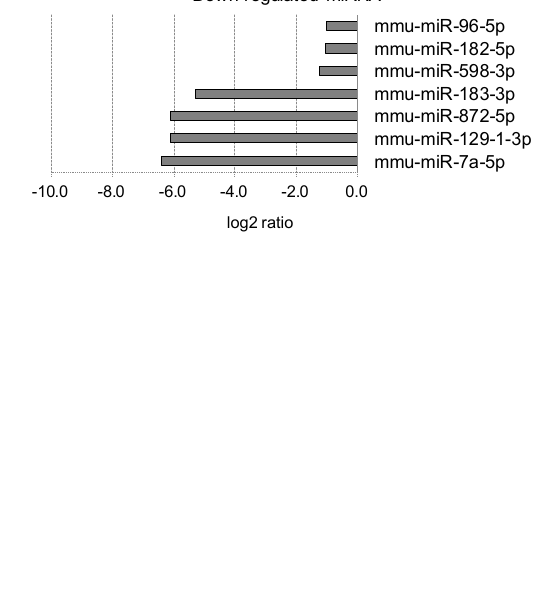
Figure 7. Retinal miRNAs affected by myopia induction. The retinal miRNAs whose expression was affected by myopia induction are listed as upregulated ( left ) and downregulated ( right ). Note that no upregulated miRNAs were detected (n.d.).